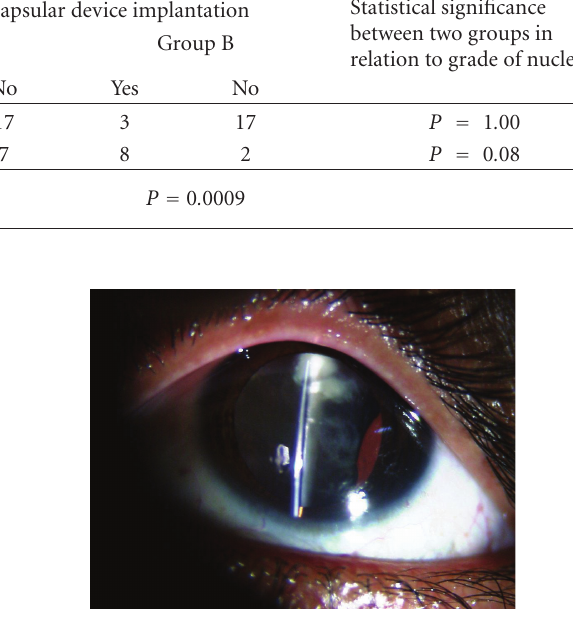
Figure 1: Lens coloboma with 180 degree